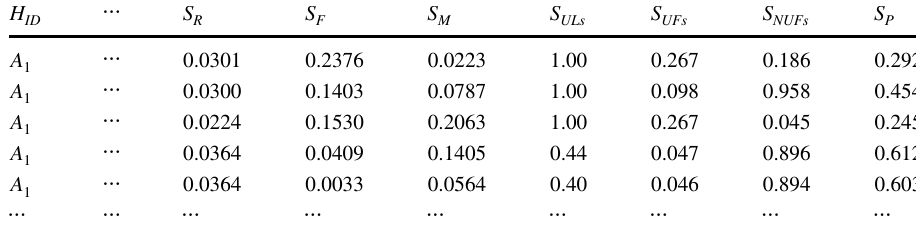
Table 7 Standardized data sheet